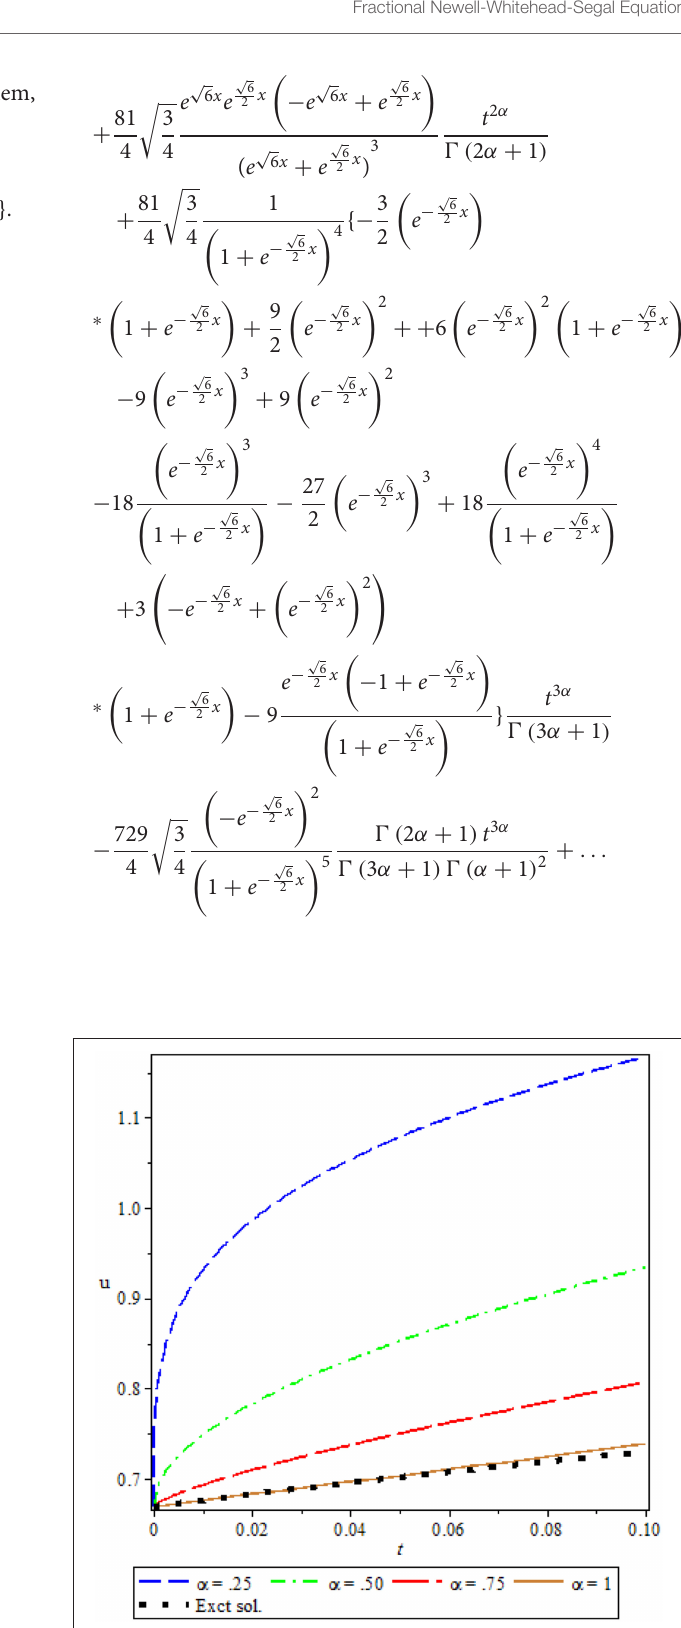
FIGURE 6 | Comparison of approx. sol. for different values of fractional order α and exact sol. at α 1, for Ex. =